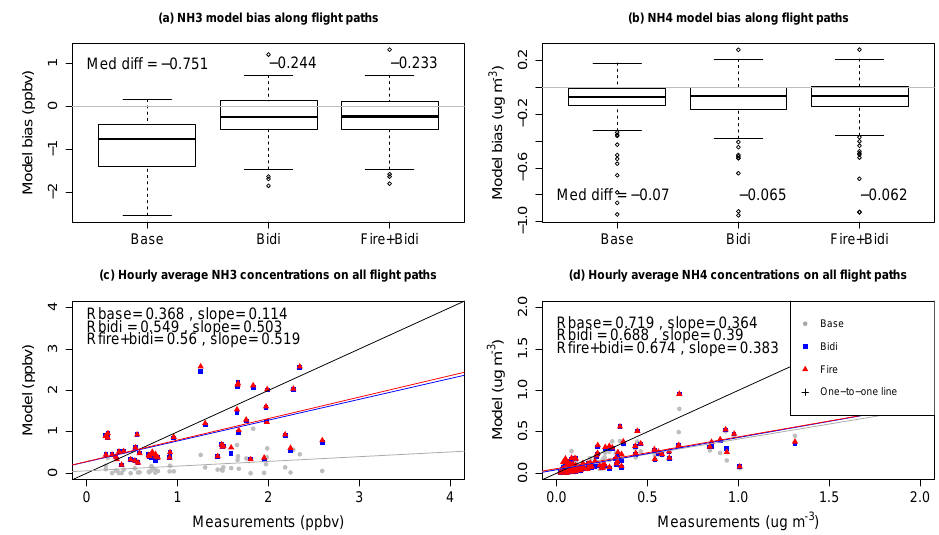
Figure 8. Hourly averages along all flight paths over the oil sands region during the summer 2013 campaign: model–measurement bias in (a) NH 3 and (b) NH + . Modelled vs. measured (c) NH 3 VMR and (d) NH + 4 model in blue, and fire + bidi model in